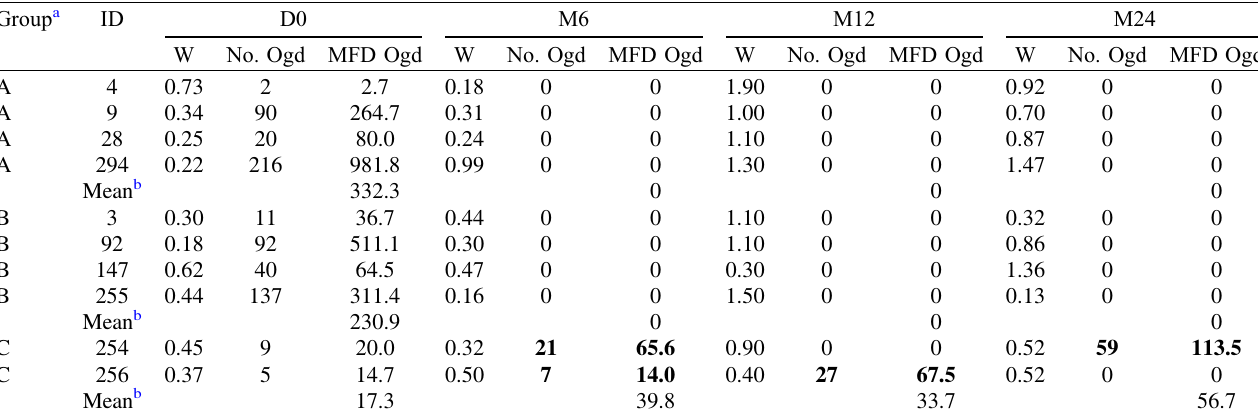
Table 3. Non- O. ochengi ( O. gutturosa and O. dukei ) MFD per gram of skin in each animal and each treatment group at D0, M6, M12, and M24. Post-treatment-positive results are shown in bold.